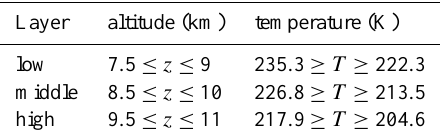
Table 1. Initial vertical positions and temperature ranges for ice- supersaturated layers (low/middle/high)